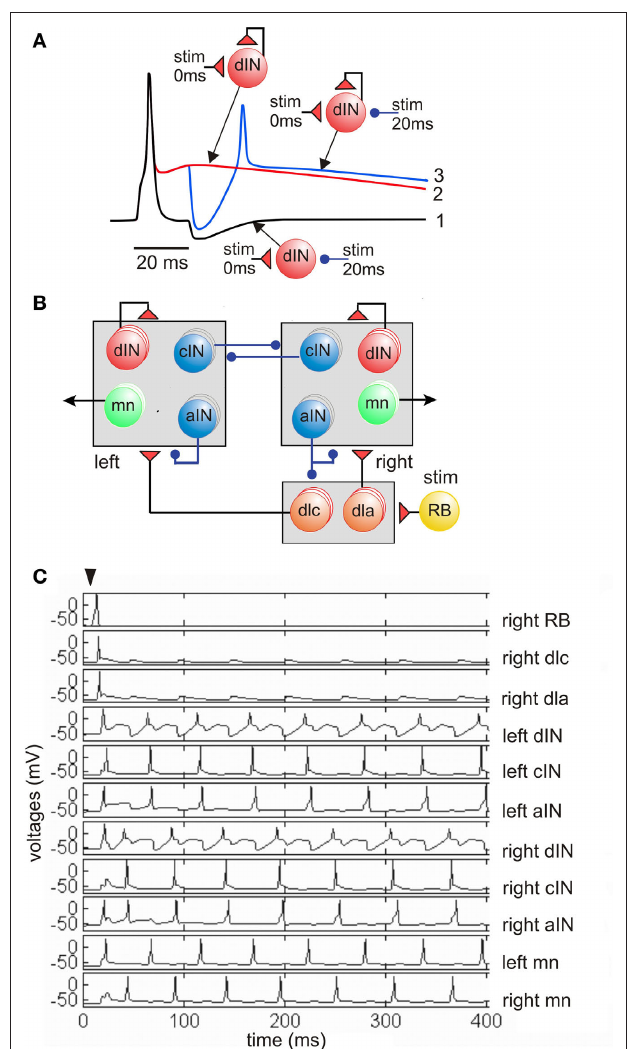
Figure  | Feedback excitation and post-inhibitory rebound hypothesis for the swimming circuit. (A) Responses of a single dIN illustrate the fundamental mechanisms. (1) Fast short excitation at time 0 makes dIN fire but short inhibition at 20 ms does not lead to rebound from the resting potential (black line). (2) when dIN feeds back long NMDA excitation, it holds the dIN depolarized but it does not fire (red). (3) if inhibition occurs during depolarization it leads to rebound dIN firing and a new cycle can start (blue). (B) The model network with populations equivalent to 30 of each type of neuron in each half- center. A skin stimulus to one RB neuron activates the network via sensory pathway interneurons. (C) Example of network swimming activity following a single RB impulse. (based on Sautois et al.,